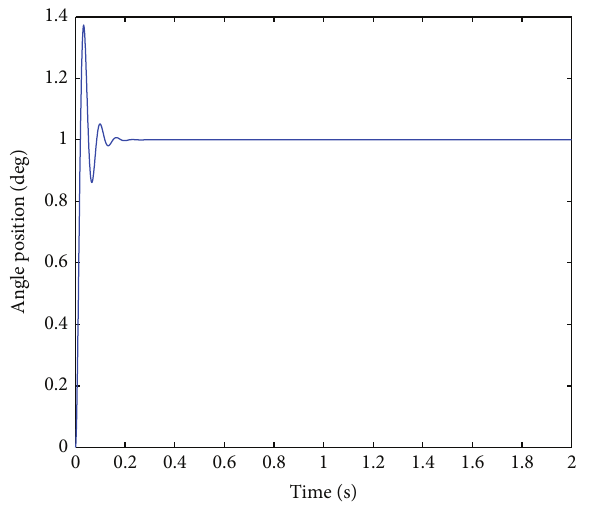
Figure 1: Step response curve of servo loop.